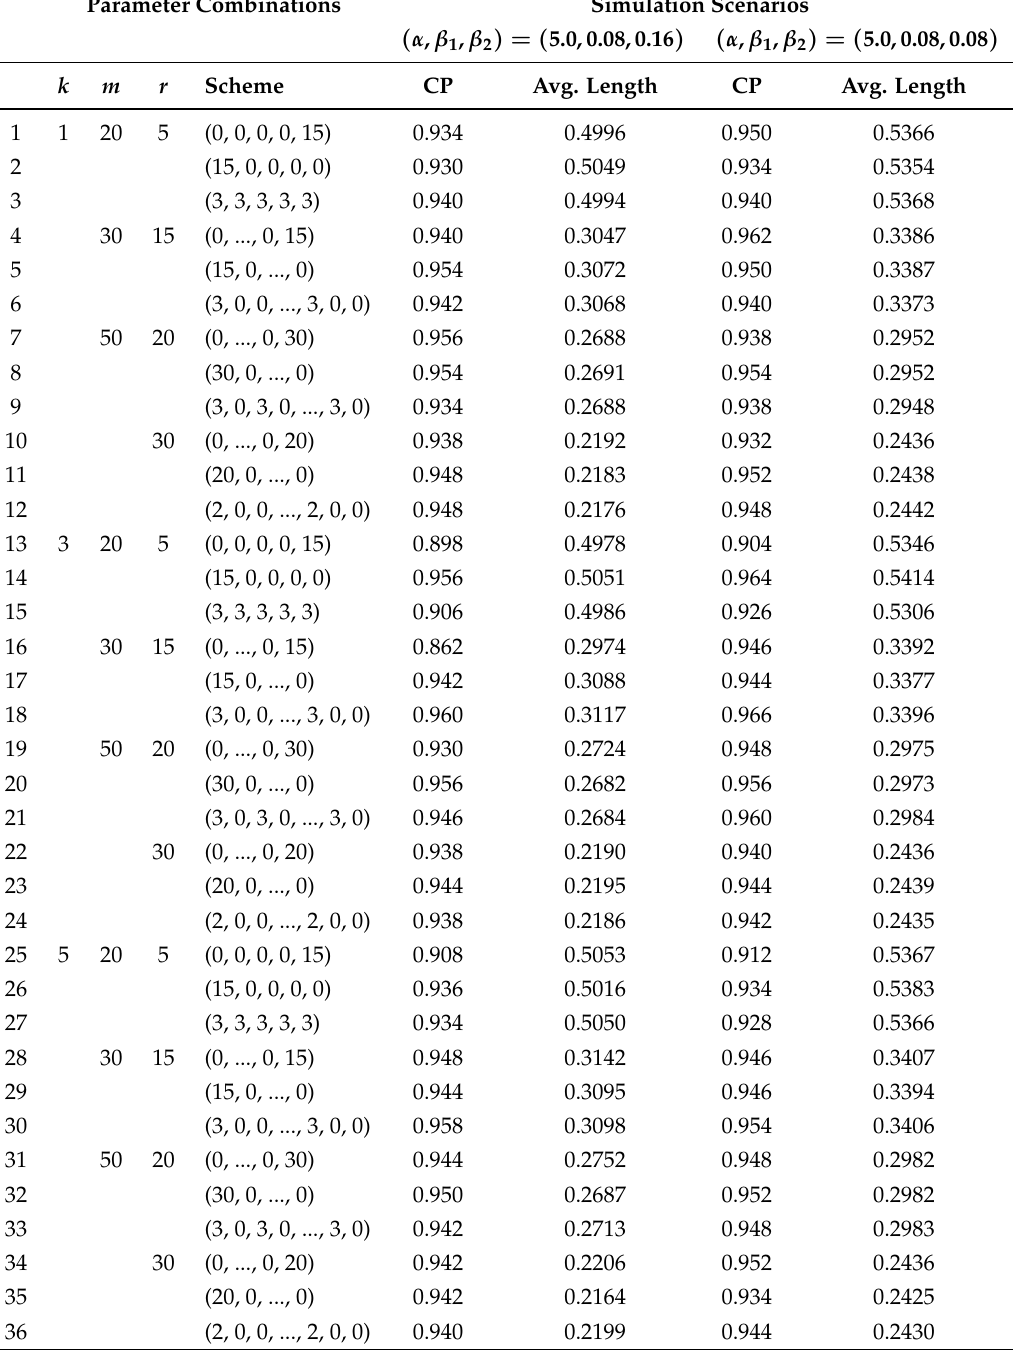
Table 5. The coverage probabilities of 95% credible intervals and their average lengths for δ under different Burr type XII